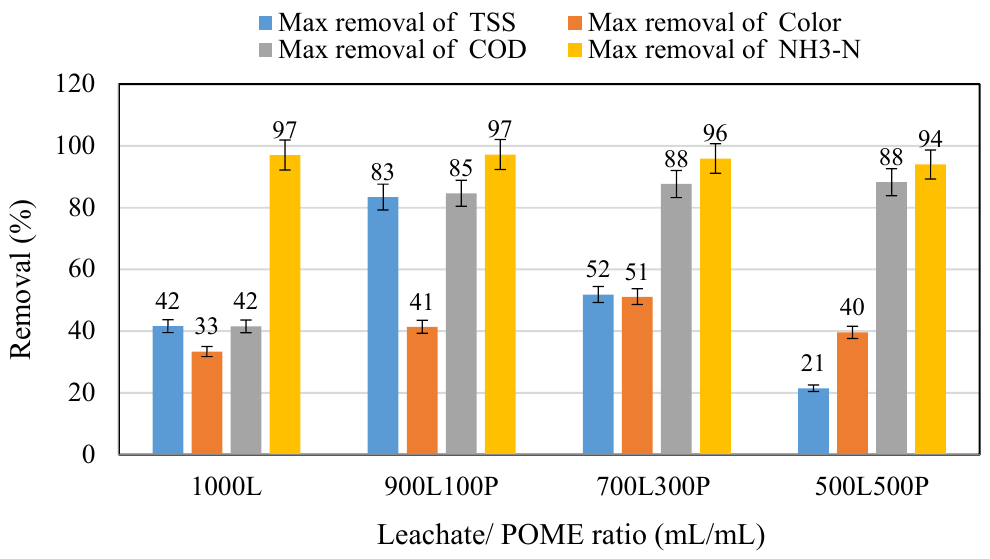
Figure 5. Effect of the leachate/POME ratios on COD, TSS, color, and NH 3 -N removal efficiency after 24 days of mixing aeration (with natural pH, aeration power 20 L/min).